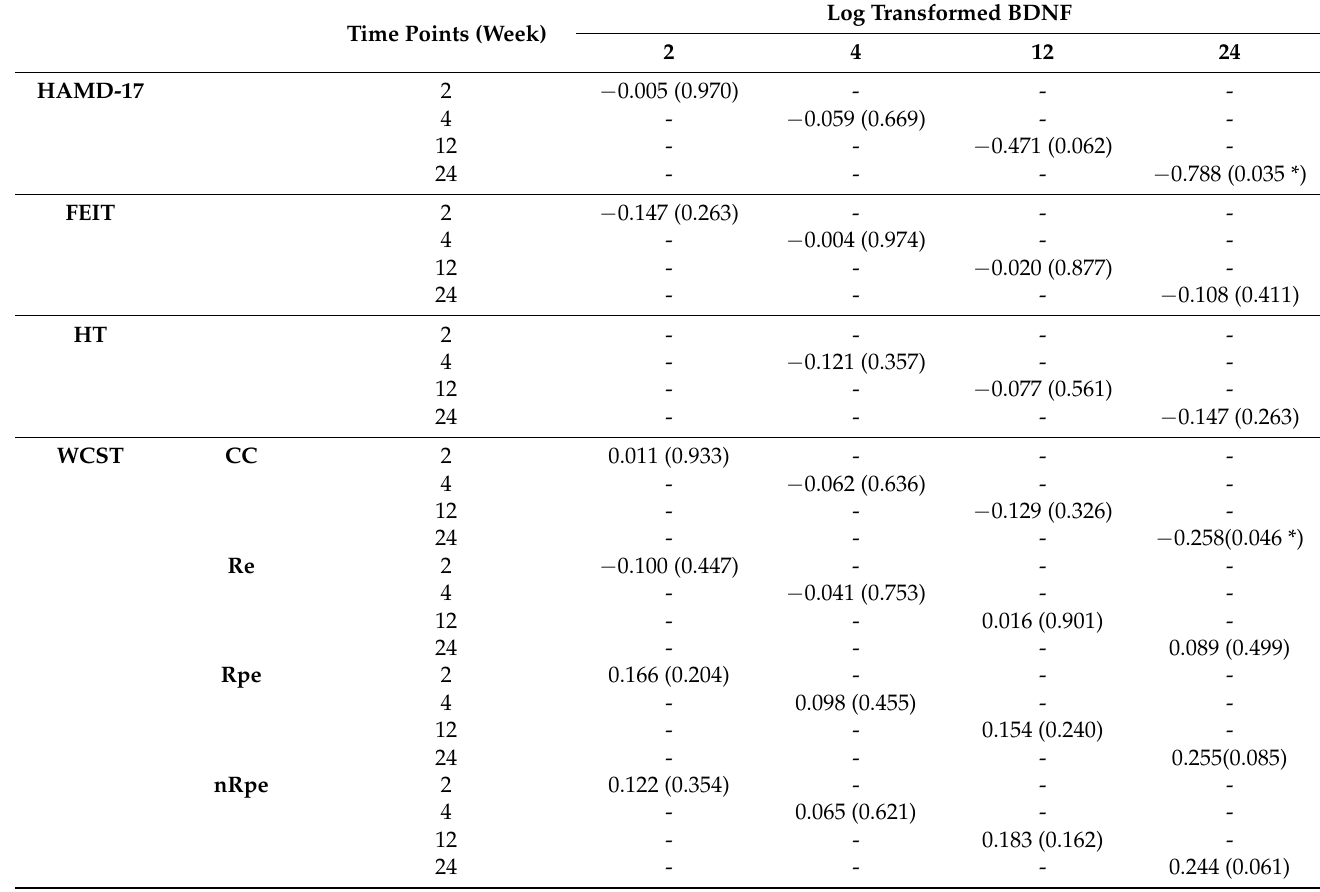
Table 6. Correlation between log transformed BDNF concentration and HAMD-17, FEIT, HT, and WCST score at each time point in active rTMS